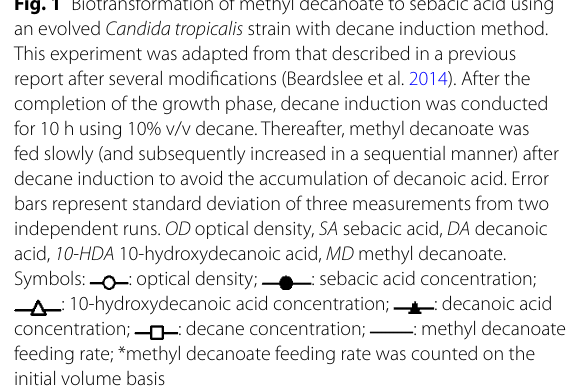
27.0 2.14 g/L sebacic acid (0.50 ± duced using this method.